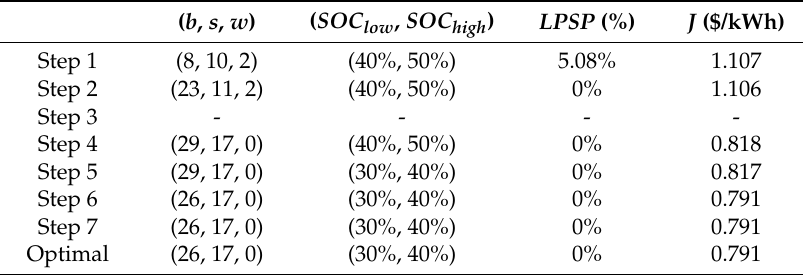
Figure 8. The reference plots for the office load. Table 7. The optimal design procedures for the office